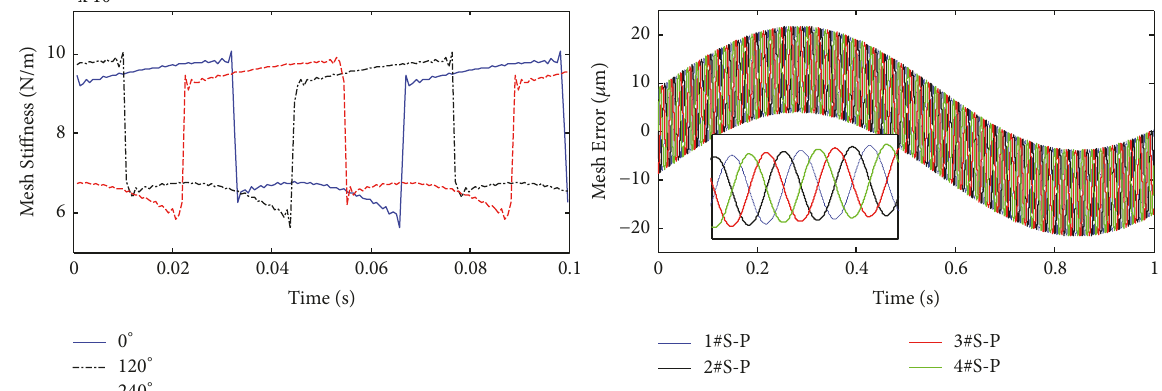
Figure 3: Time-varying meshing stiffness and error considering the relationship of mesh